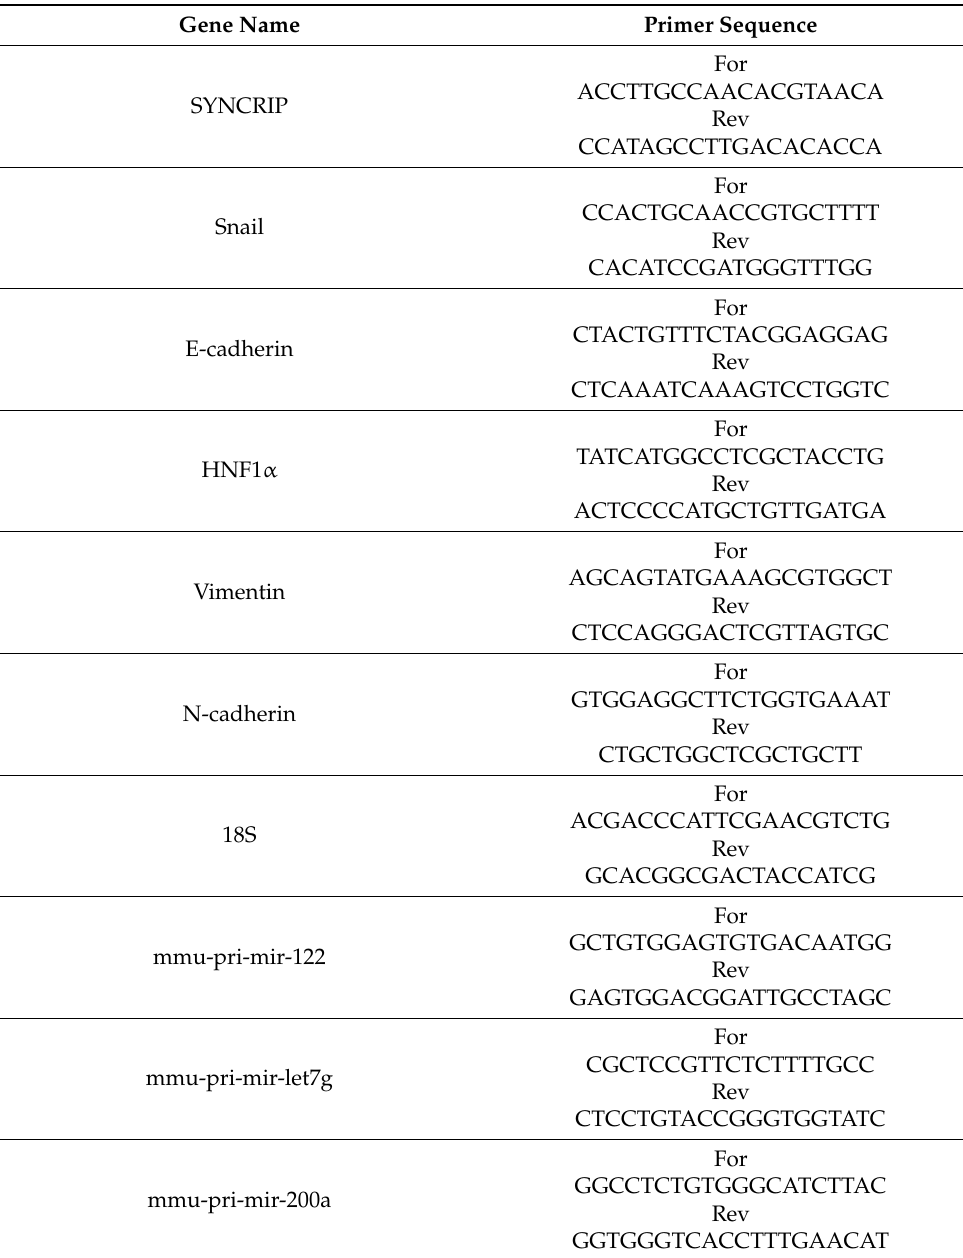
Table 1. Primers used for qPCR